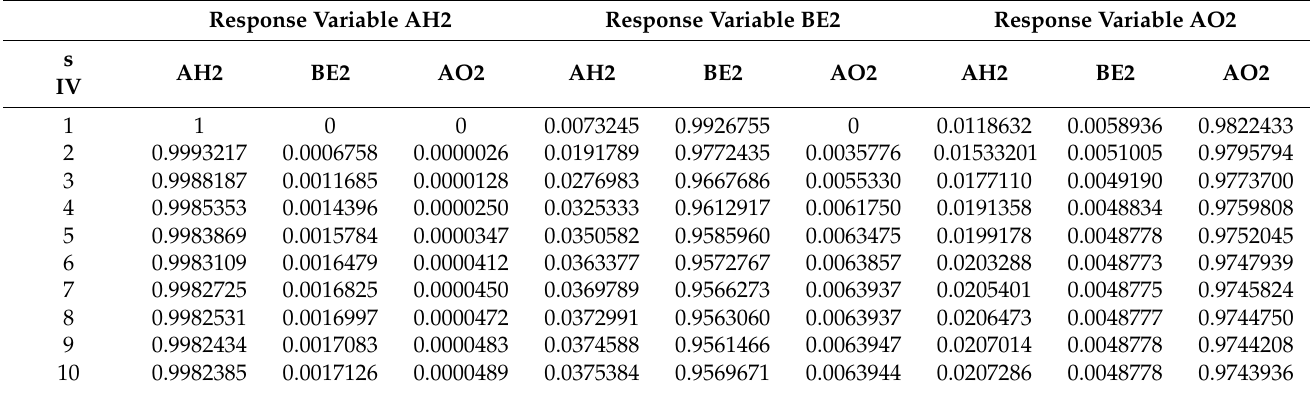
Table 10. Variance decomposition results of AH2, BE2 and